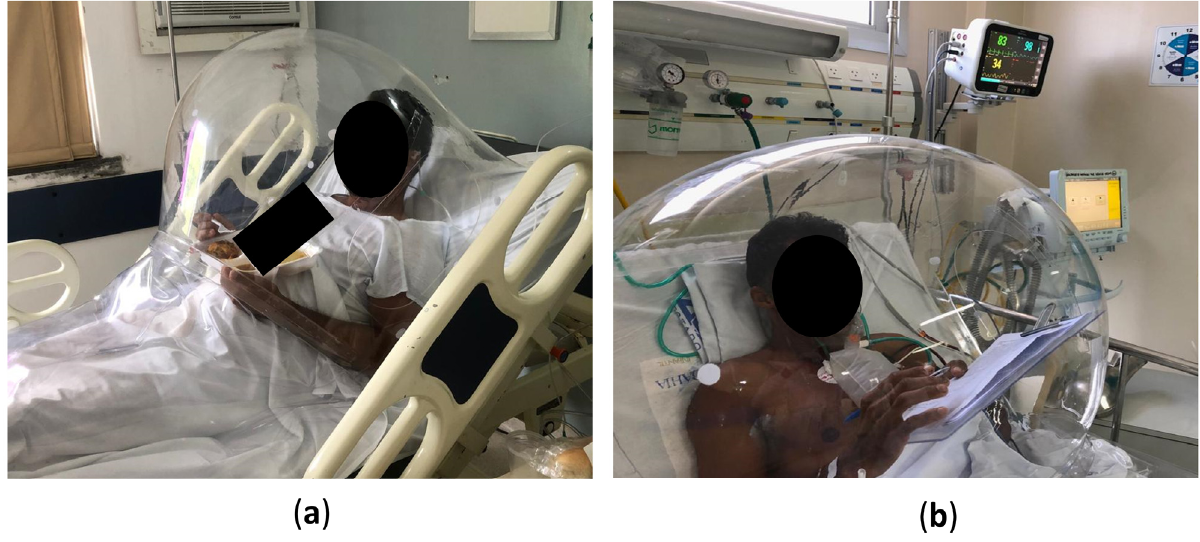
Figure 10. Study participants used the device ( a ) during feeding and ( b ) during the response to the assessment questionnaire. assessment